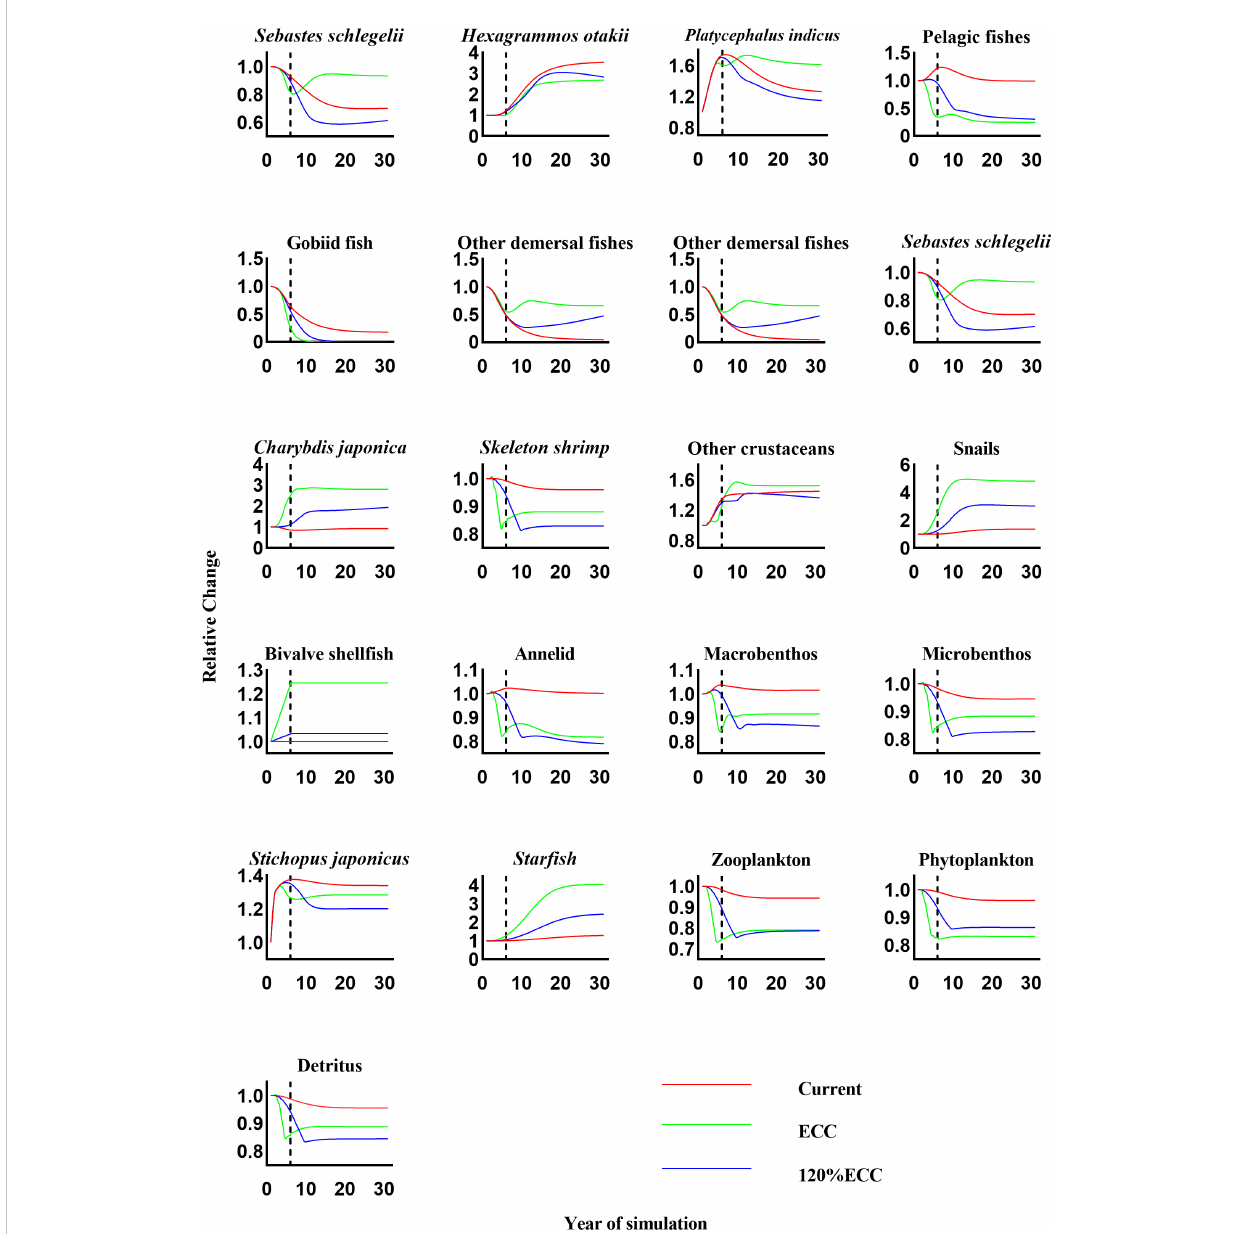
FIGURE 4 The relative changes in biomass of each functional group under three scenarios (current, ECC, and 120% ECC) of bivalve biomass augmentation in the study marine ranching ecosystem model were predicted. The biomass of bivalves was kept constant after the dashed line. ECC, ecological carrying capacity; 120%ECC, 120% ecological carrying